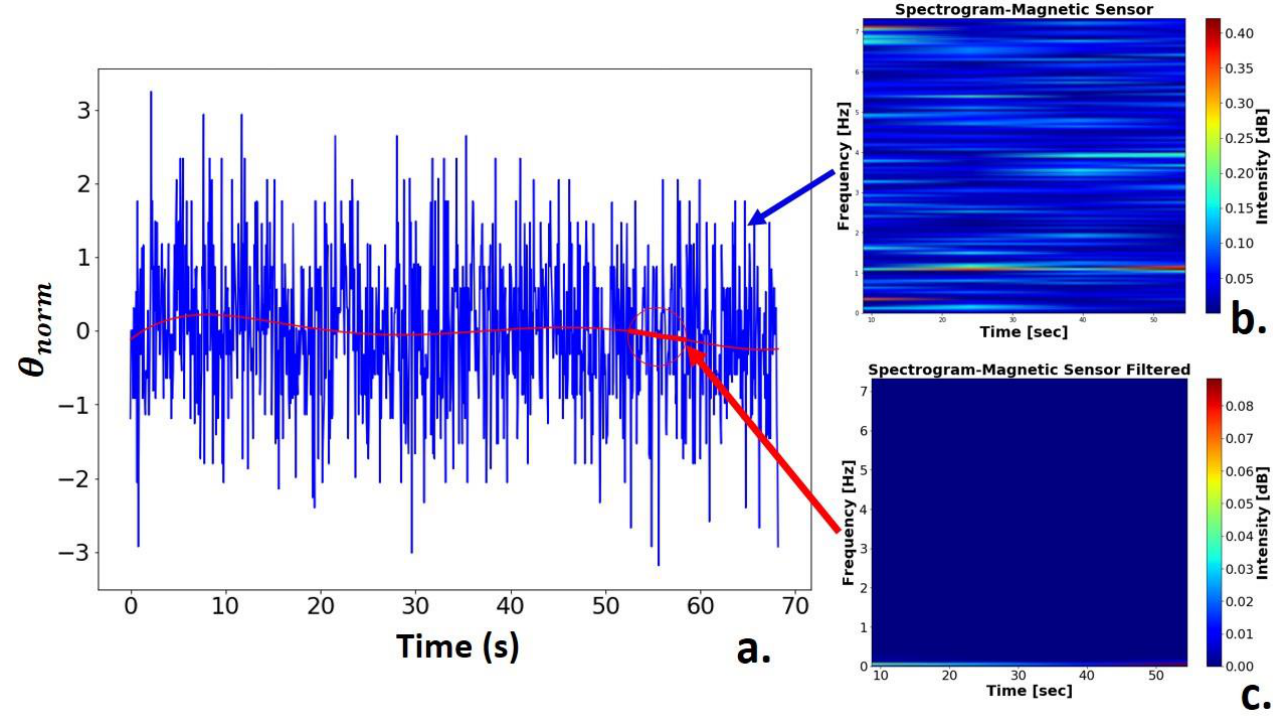
Figure 18. Geomagnetic signal: ( a ) Normalized geomagnetic signal; ( b ) Sensor noisy signal spectrogram; ( c ) Filtered signal spectrogram.